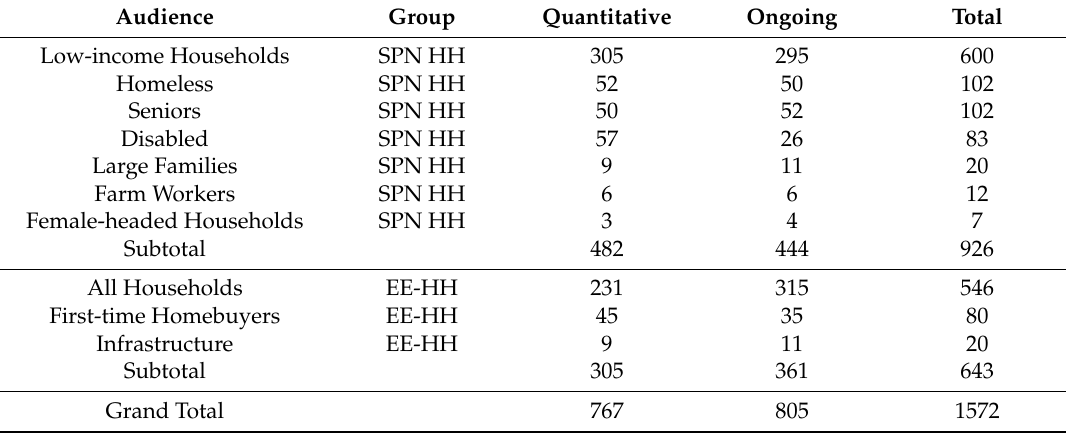
Table 7. Audience Types by Evaluation Identifications. In general, the audience types maintained a balance of quantitative and ongoing objectives, except for the Disabled, which skewed quantitative.